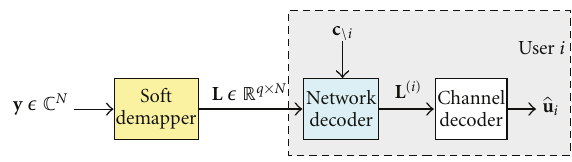
Figure 8: Receiver scheme for node i . The demapper provides the decoder with L vectors relative to received symbols. Network decoder uses knowledge of symbol c \ i to calculate L ( i ) vector, that is, the L vector of c i .